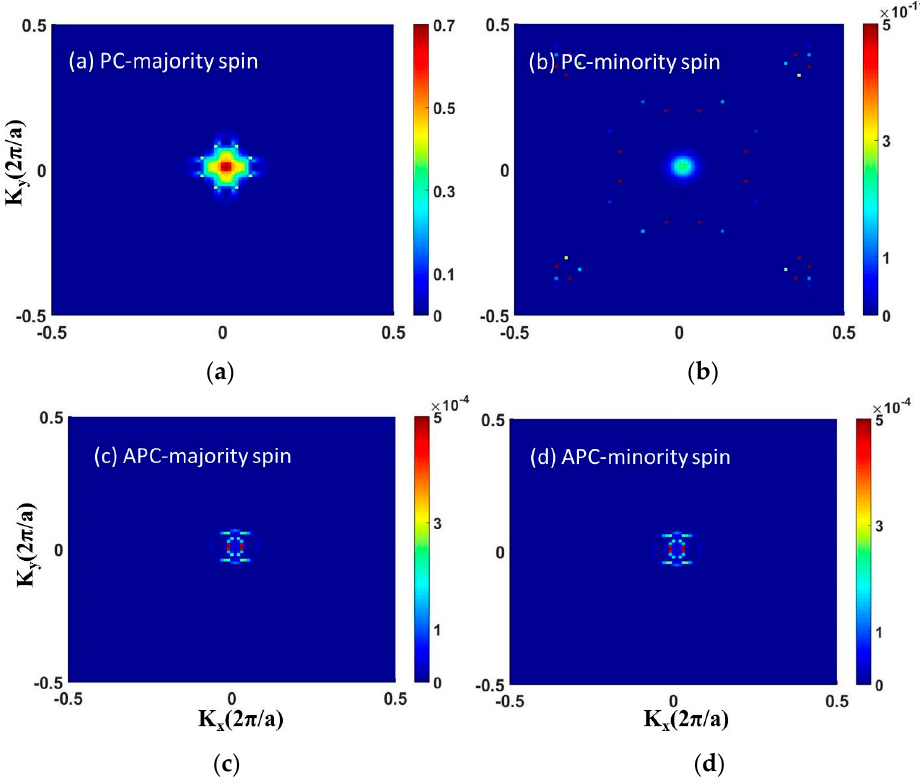
Figure 9. The k // -resolved transmission coefficients of the MnCo T -terminated structure at the Fermi